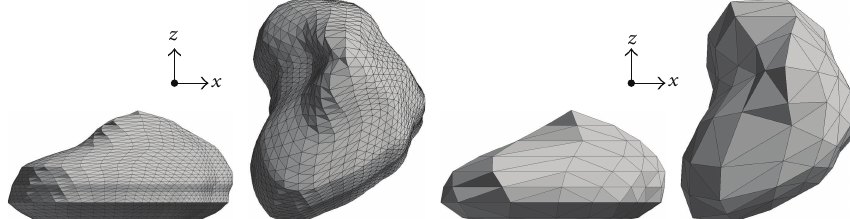
Figure 8: Two views of a reconstructed grain with (left) fine 3D mesh and (right) coarse 3D mesh,